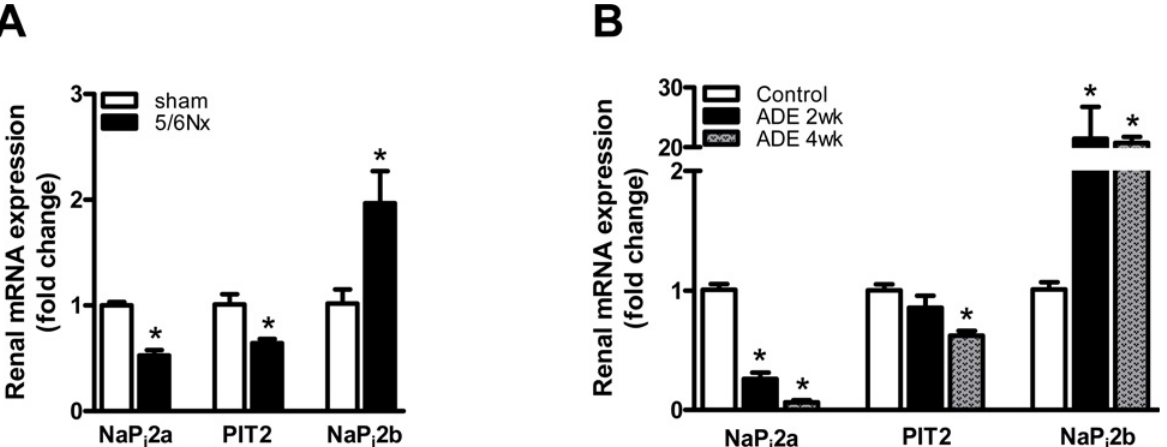
Fig 5. CKD development altered renal expression of tubular phosphate transporters. (A) mRNA expression of the renal NaP i 2a, PIT2 and NaP i 2b in mice with CKD development induced by either 5/6Nx (black bars) or (B) 2 weeks (black bars) and 4 weeks (gray bars) ADE treated mice ADE treatment, when compared to sham-operated (white bars) or control mice (white bars), respectively. Data are mean ± SEM. * : p < 0.05 compared to either sham- operated or control mice.